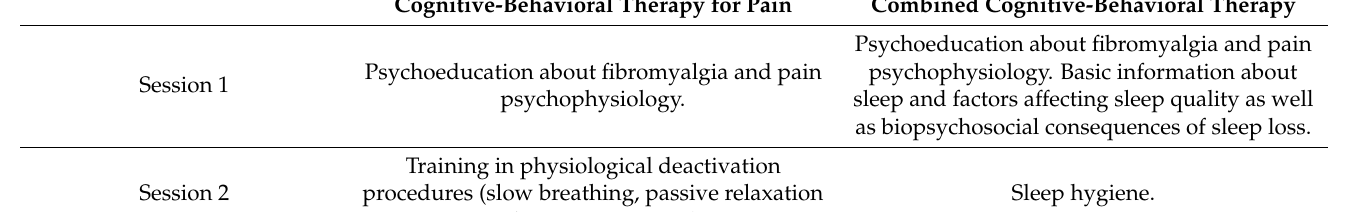
Table 1. Components of Cognitive-Behavioral Therapy for Pain and Combined Cognitive-Behavioral